Question: Describe this figure in one sentence.
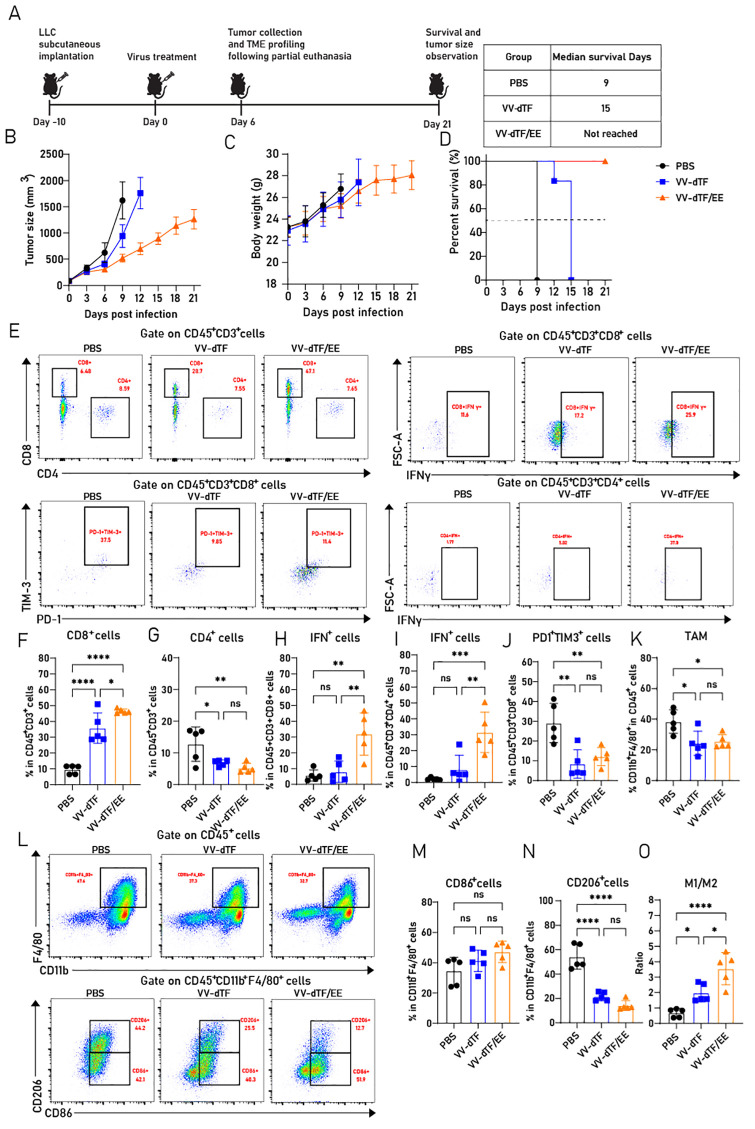
Answer: VV-dTF/EE improves anti-tumor efficacy by increasing CD8+ T cell infiltration and relieving immunosuppression. (A) Schedule of LLC tumor implantation and VACV treatment. C57BL/6 mice harboring subcutaneous LLC tumors were randomized and injected with an intratumoral dose of 1x10 6 PFU VV-dTF or VV-dTF/EE. PBS was used as a control. (B) mean tumor size after treatments, body weight changes (C, D) overall survival are plotted (n=6). The median survival rate is shown in the table above the (D, E) Representative flow cytometry scatterplots for F to J, each panel represents an individual sample. (G–K) Percentages of CD8+ (G) , CD4+ (H) , CD8+IFNγ+ (I) , CD4+IFNγ+ (J) , and PD1+TIM3+ (K) T cells in LLC tumor tissues. (L) Levels of tumor associated macrophages (TAMs) in non-infected and infected LLC tumor tissues. (M) Representative flow cytometry scatterplot of TAM [in (L) ] and M1 (in N), M2 [in (O) ] macrophages. (N, O) Levels of M1 (N) and M2 (O) macrophages in non-infected and infected LLC tumor tissues. (P) Ratios of M1 to M2 macrophages in tumor tissues. All data were derived from individual samples; no concatenation was applied. Statistical analysis was performed with one-way ANOVA with Tukey’s correction for the data shown in (F–K) and (M–O) . All data are presented as mean values ± SD. *p < 0.05; **p < 0.01; ***p < 0.001; ****p < 0.0001; ns, not significant.